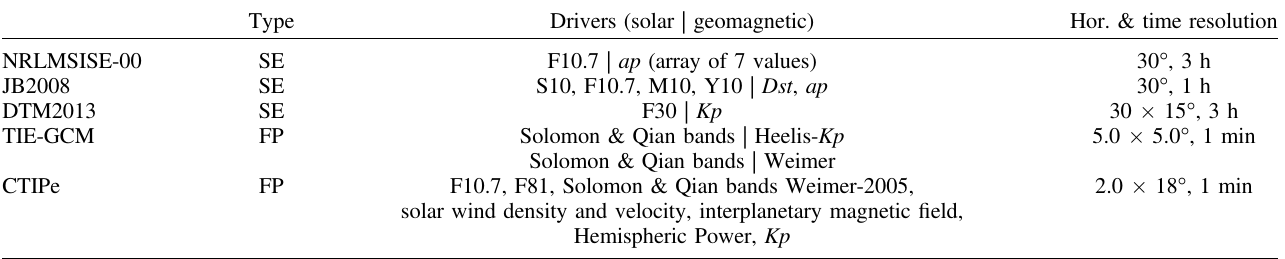
Table 1. Thermosphere and upper atmosphere models used in the assessment.